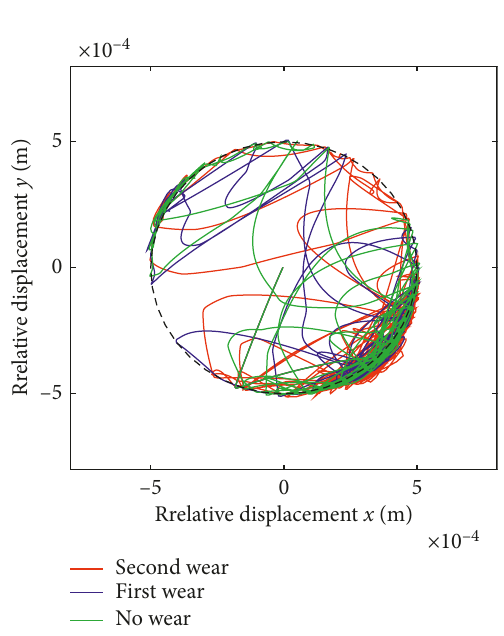
Figure 26: Shaft trajectory of joint B